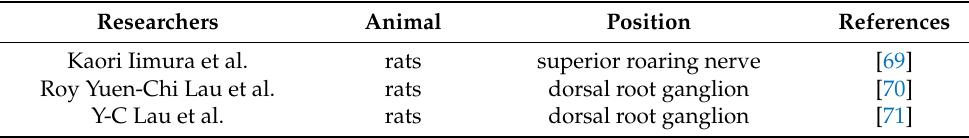
Table 4. Animal experiments using DC for osteoporosis.